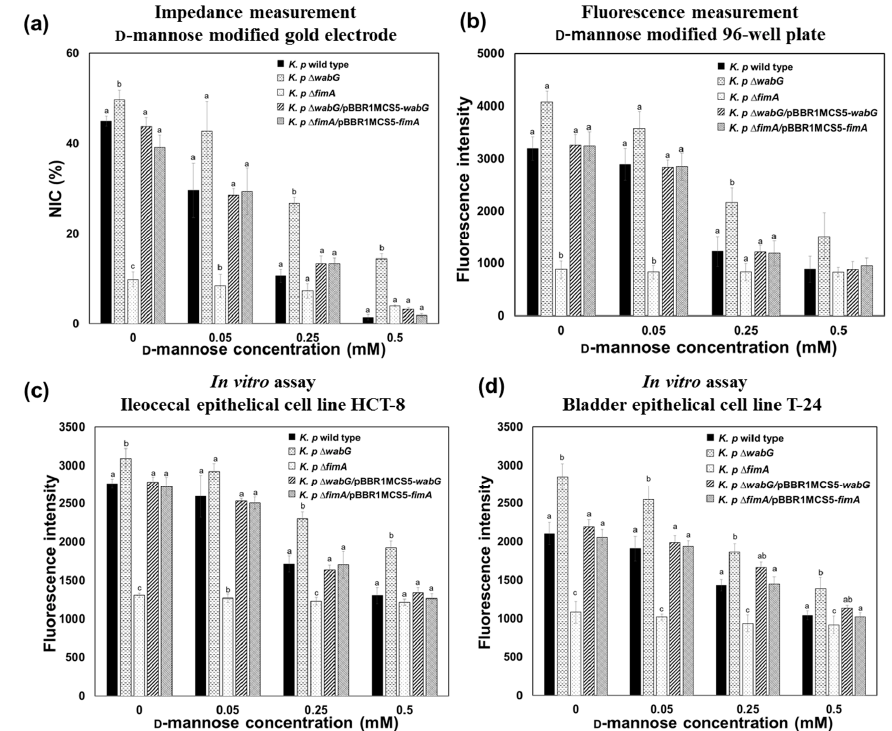
Figure 6. Competition assay results showing the role of mannose on fimbriae-mediated adhesion of K. pneumoniae 2242 wild type and its isogenic mutants to the epithelial cells. The results